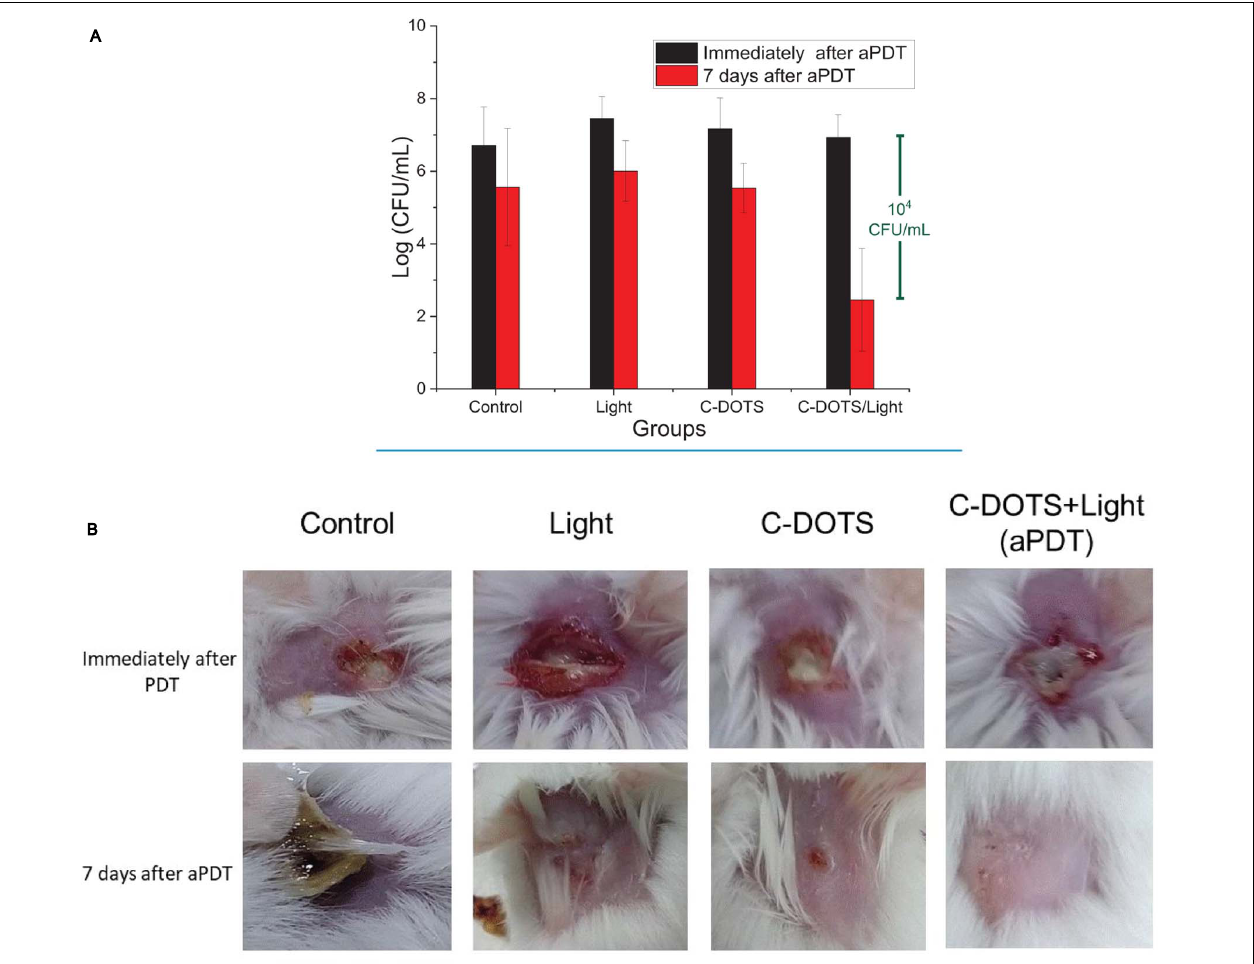
FIGURE 8 | In vivo aPDT. (A) Log (CFU/mL) of S. aureus bacteria in mouse immediately aPDT (black blocks) and 7 days after the procedures (red blocks) in control, light, C-DOTS, and C-DOTS + light (aPDT) groups ( n = 3). (B) Photographs of mice wounds infected with S. aureus . Same groups as panel (A) ( n = 3). The C-DOTS concentration was 6.9 mg/mL; the wound was infected with 10 8 cells/mL of bacteria suspension; the LED light was applied with the dose of 60 J/cm 2 (28 min) at 450